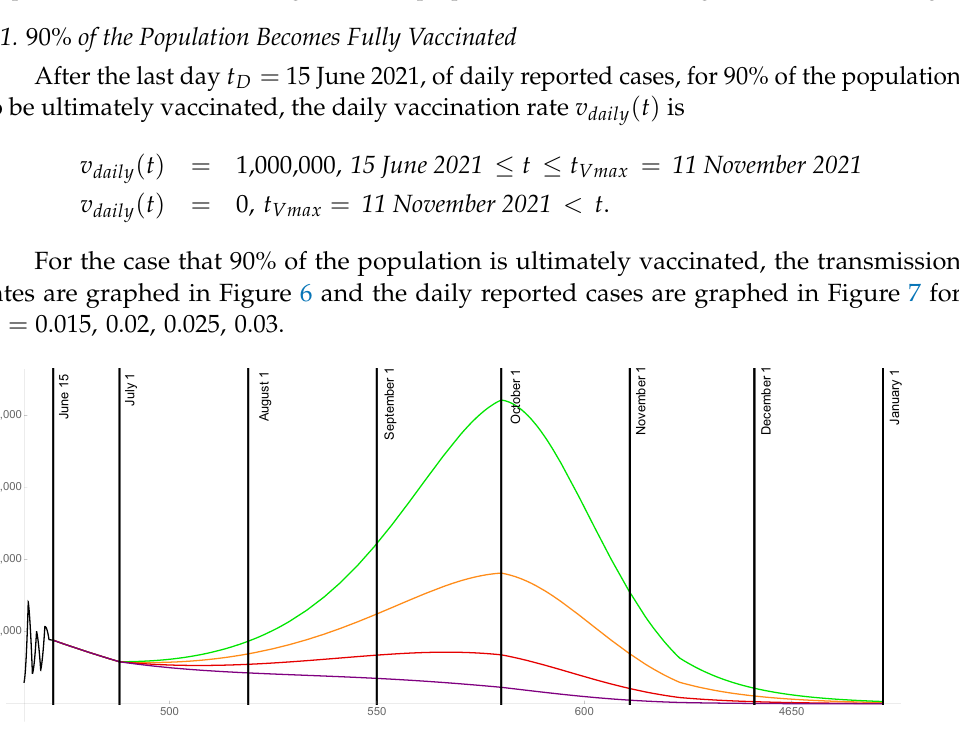
Figure 6. Transmission rates for the level of social distancing resumption ω = 0.03 (green), ω = 0.025 (orange), ω = 0.02 (red), ω = 0.015 (purple). The ultimate vaccinated population reaches